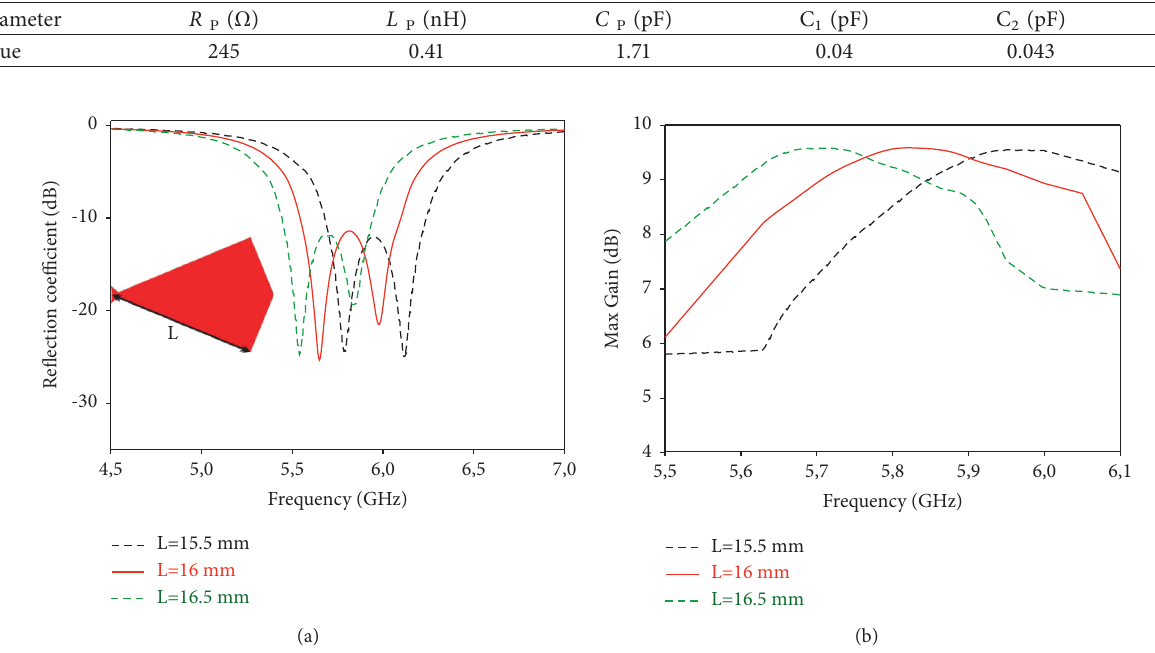
Table 2: Optimized lumped parameter